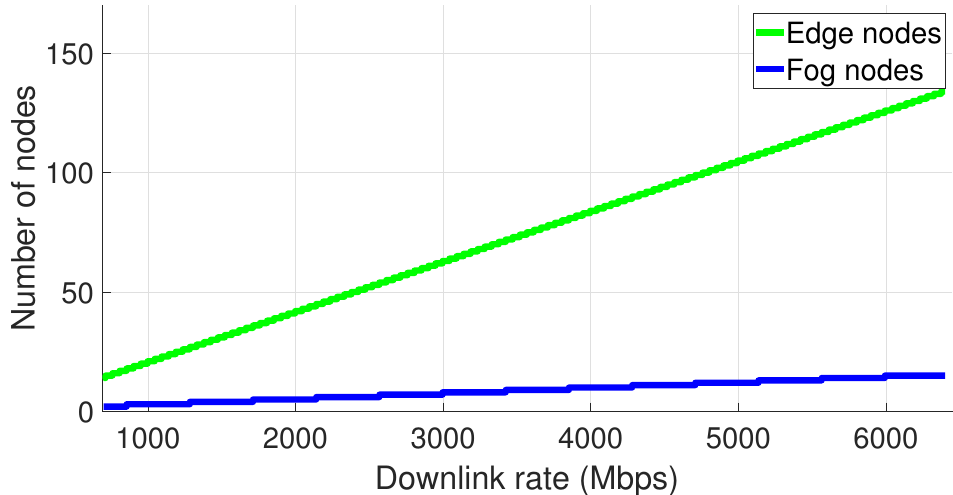
Figure 9. Evolution of the number of edge and Fog Nodes according to the downlink rate availability from the private 5G